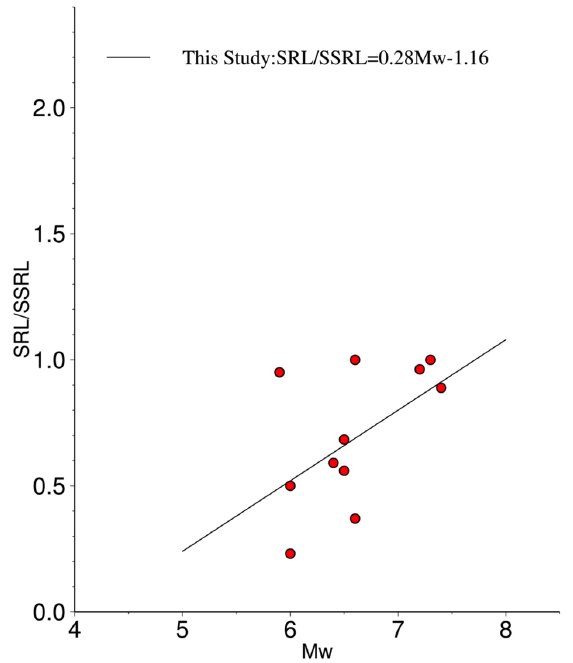
Figure 10. Ratio of SRL / SSRL versus M quakes.